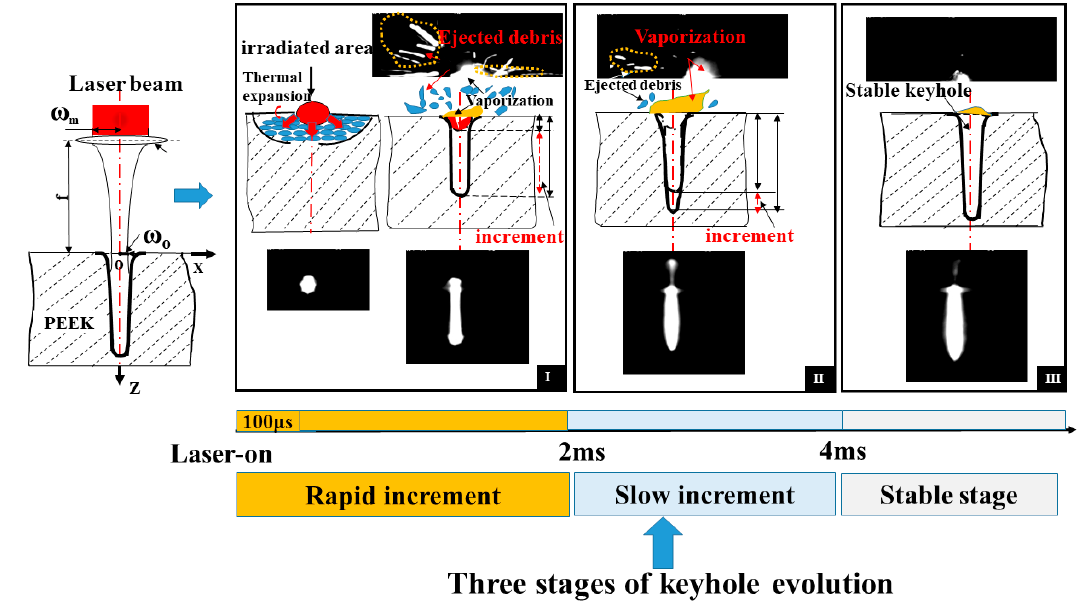
Figure 12. Material removal mechanism during the single-pulse laser drilling of PEEK.